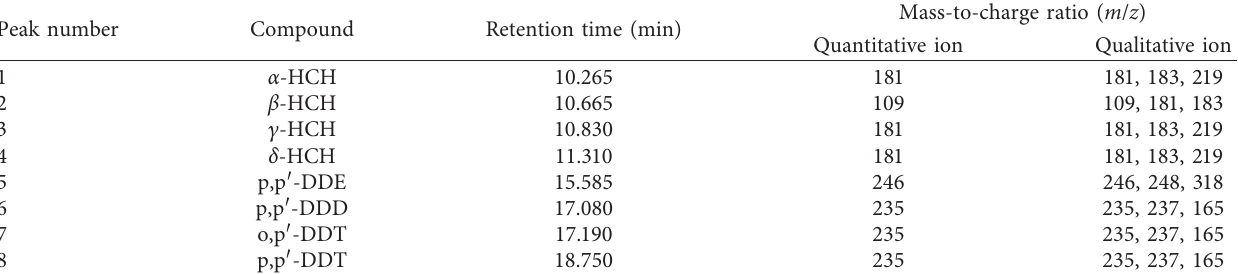
Table 1: Retention time and quantitative and qualitative ions of 8 OCPs.